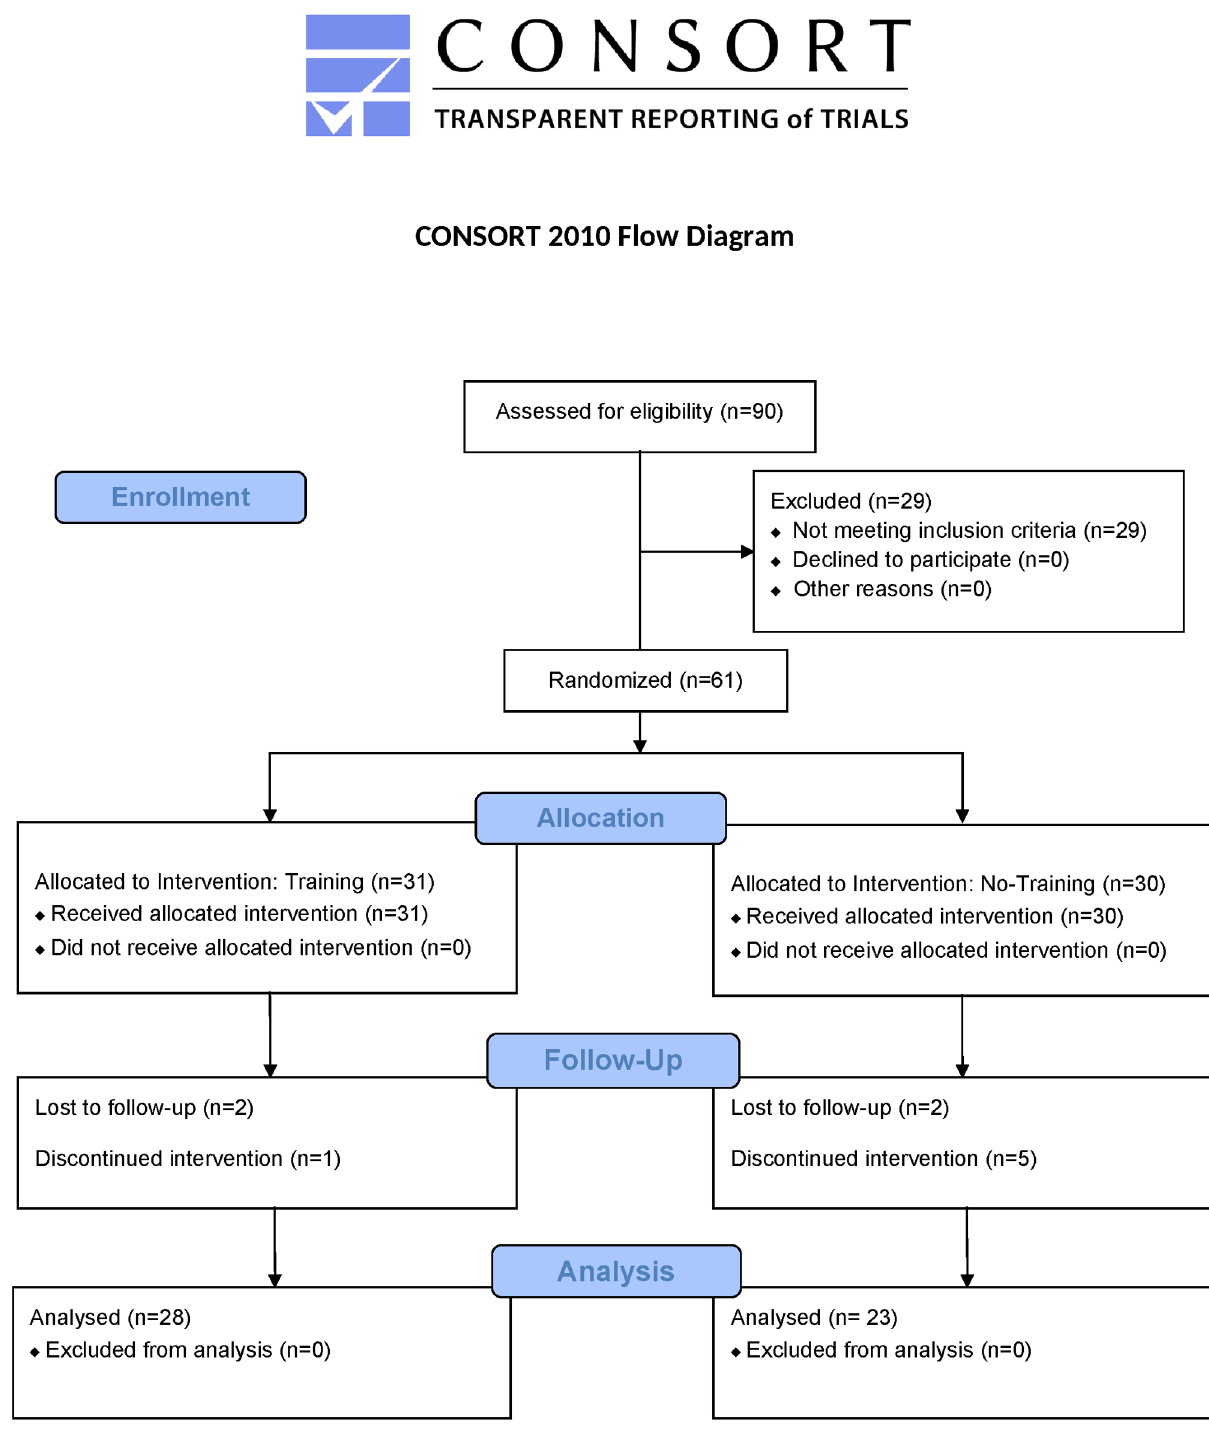
Fig 1. CONSORT participant flow